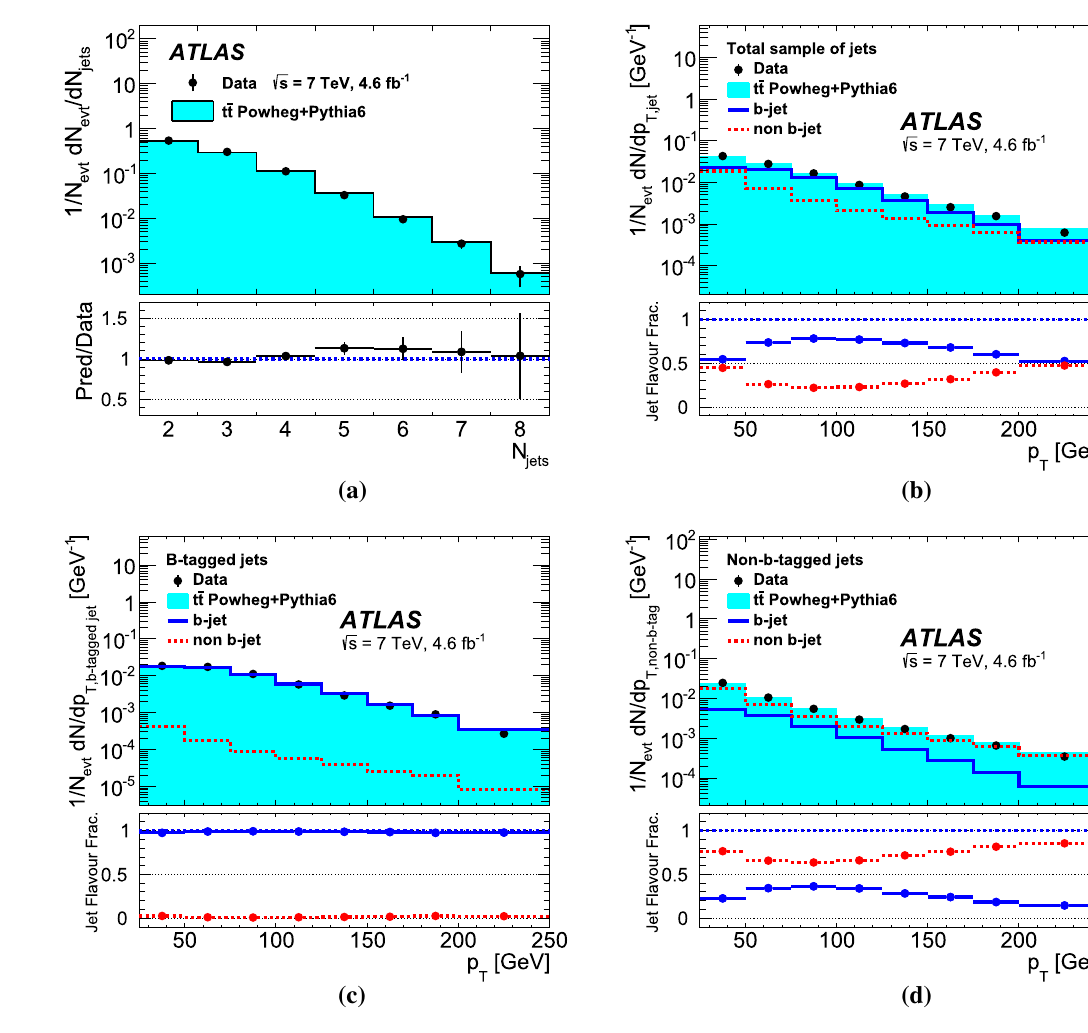
as a function of jet p T are also compared with data. These distributions are normalised to the total number of selected events in data or MC